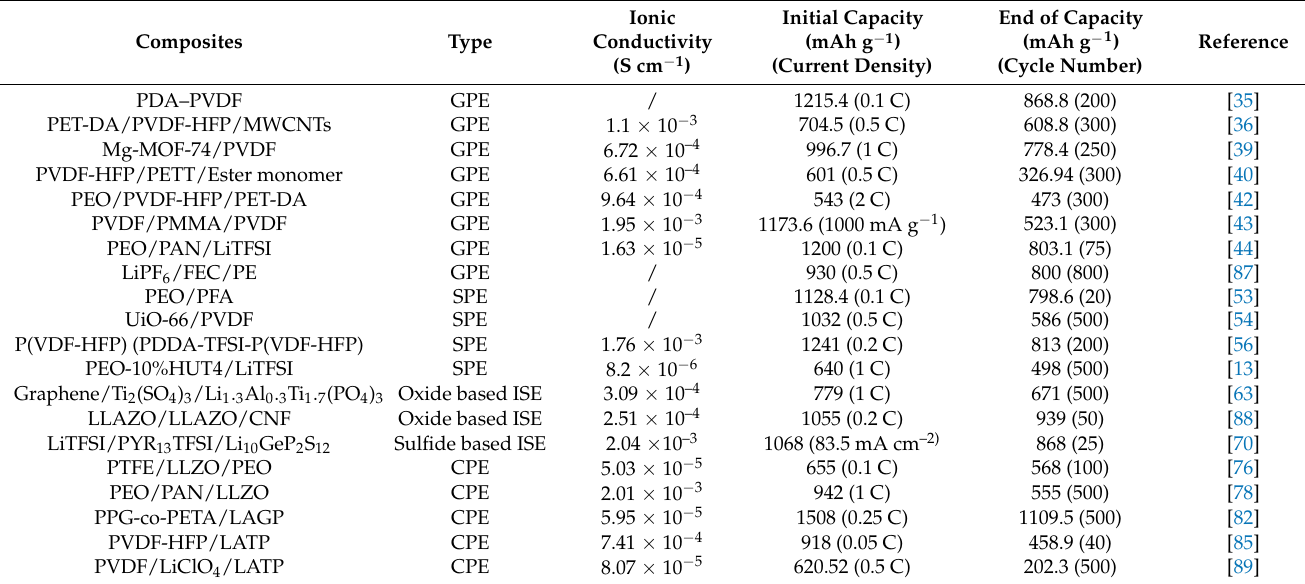
Table 1. Performance of electrolytes with different composites.